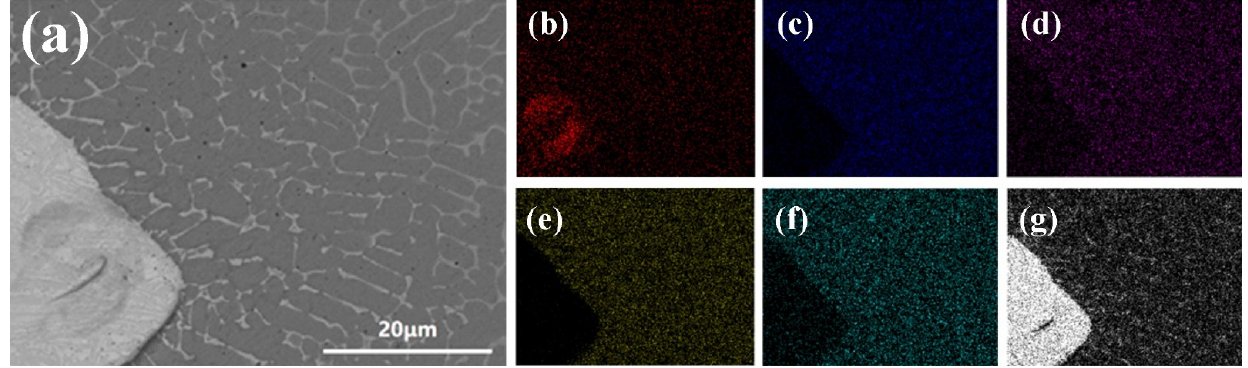
Figure 7. EDS element mapping of CoCrFeNi HEACC (40 wt.% WC). ( a ) SEM image of CoCrFeNi HEACC (40 wt.% WC); EDS element mapping of CoCrFeNi HEACC (40 wt.% WC): ( b ) C; ( c ) Cr; ( d ) Ni; ( e ) Fe; ( f ) Co; ( g ) W.